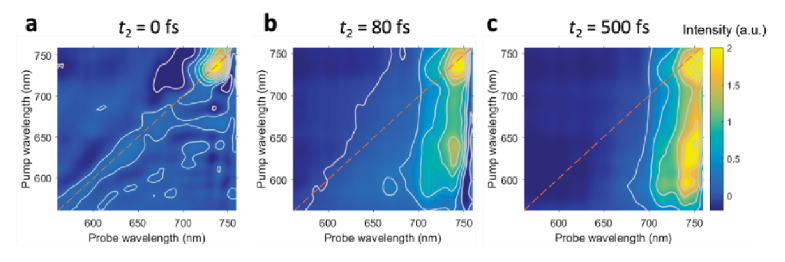
Fig. 1. (a) – (c) 2DES maps for waiting times t 2 of (a) 0 fs, (b) 80 fs and (c) 500 fs for an excitation density of 2x10 18 cm −3 at 1 kHz repetition rate. Initially, a non- thermal carrier energy distribution is excited. After undergoing carrier-carrier scattering, carriers form a thermalized distribution with a temperature higher than the lattice. Through carrier-phonon scattering, the carriers subsequently cool down until they reach an equilibrium with the lattice temperature. We extract the bleach kinetics for several energies along the diagonal of the 2DES map for a quantitative analysis (Fig. 2a). From exponential fits, we obtain characteristic carrier thermalization times from 8 to 85 fs with a strong dependence on excess energy (Fig. 2b). Faster scattering rates are found for carriers at higher energies above the band edge, in agreement with an approximately parabolic band dispersion near the band minima. Further, we observe a dependence of thermalization times on photo-excited carrier density. We conclude that thermalization occurs dominantly via carrier-carrier scattering at the investigated fluences. The reported thermalization times set the limit for carrier mobilities in lead-halide hybrid perovskites to 400 cm 2 ⁄Vs at carrier densities lower than 2x10 18 cm -3 .